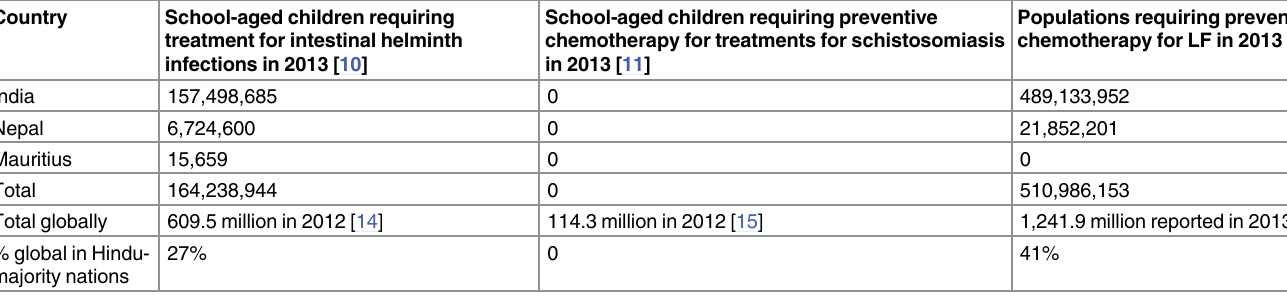
Table 2. NTDs in Hindu-majority developing countries: India, Nepal, and Mauritius.